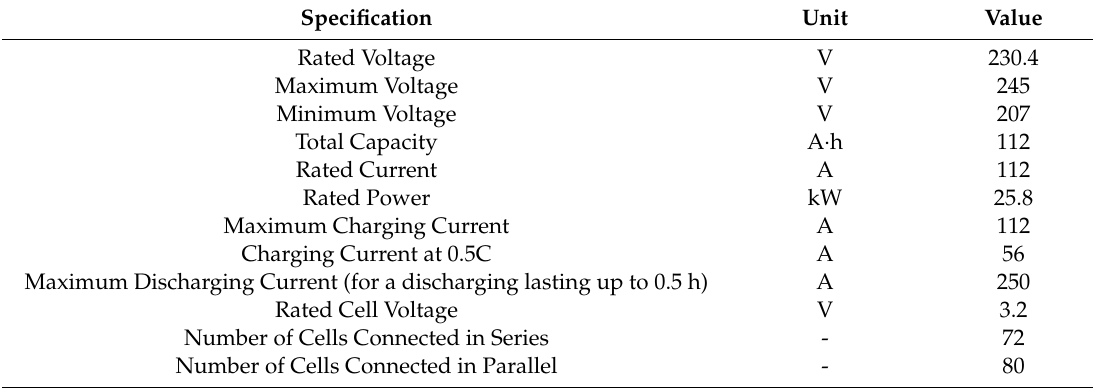
Table 2. Parameters of Li-ion battery installed in the LINTEˆ2 laboratory.